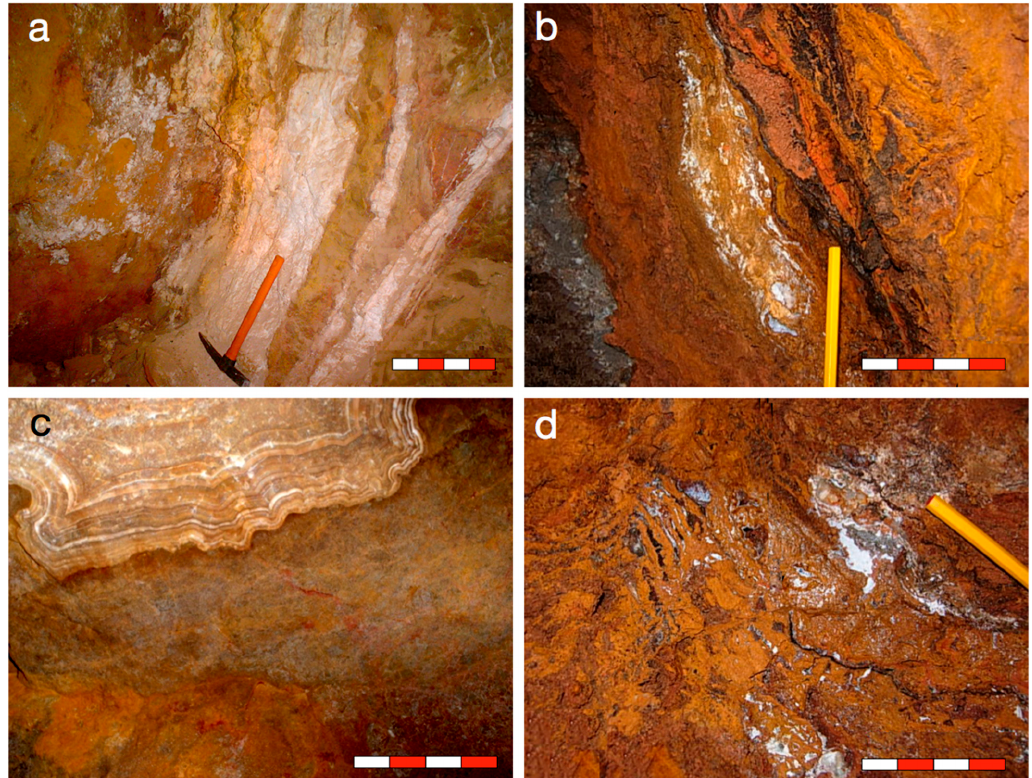
Figure 2. ( a ) The vein ore at Srâa Abd El Kader and (b,c,d) the karst type at Grand Pic [20,21]. Scale bar = 20 cm in (a), 10 cm in ( b ), 35 cm in ( c ), and 10 cm in ( d ).